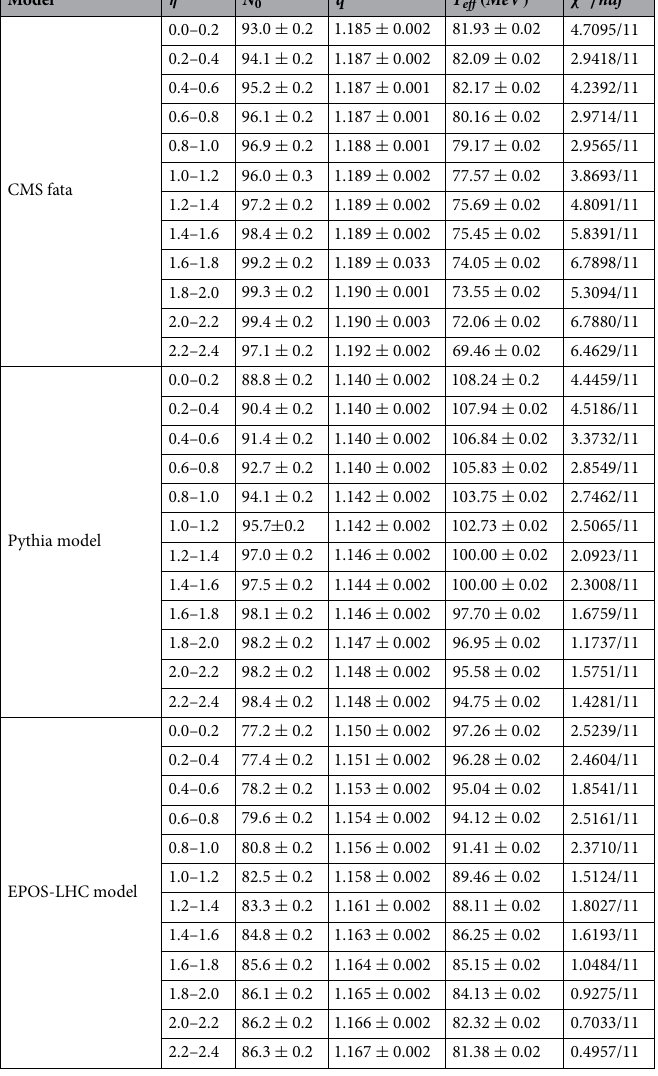
Table 2. The values of free parameters ( q and T eff ), normalization constant ( N 0 ), and χ values of η from 0 to 2.4 in steps of 0.2 using thermodynamically consistent Tsallis distribution function given by Eq. (8) are shown here for the experimental data, Pythia model, and EPOS